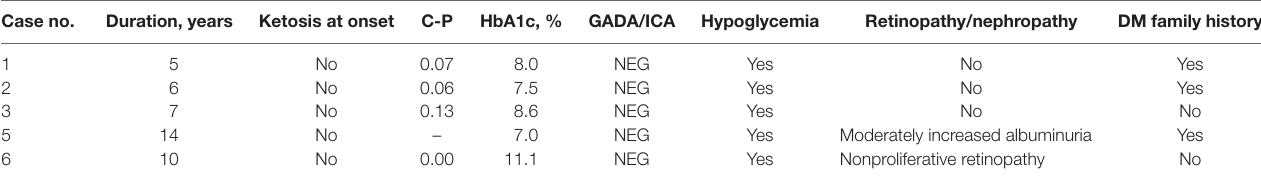
Table 2 | Clinical features of DM in patients with Wolfram